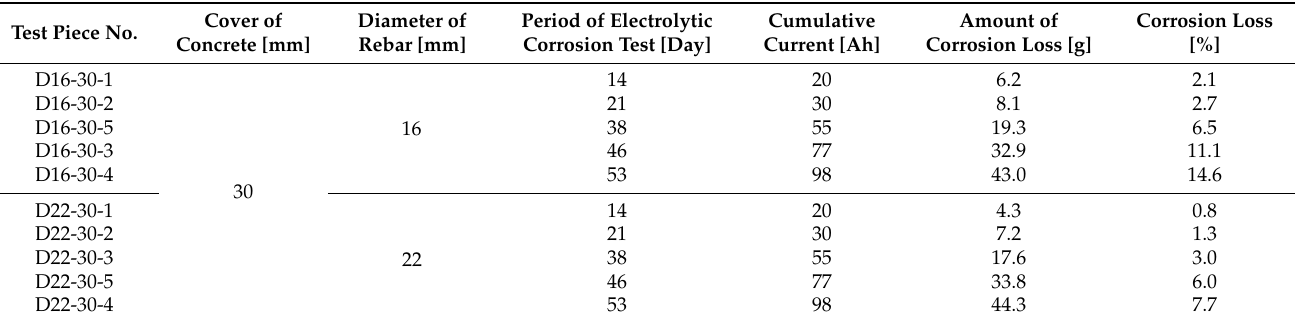
Table 4. Corrosion loss of the rebar extracted after the electrolytic corrosion test. Test Piece